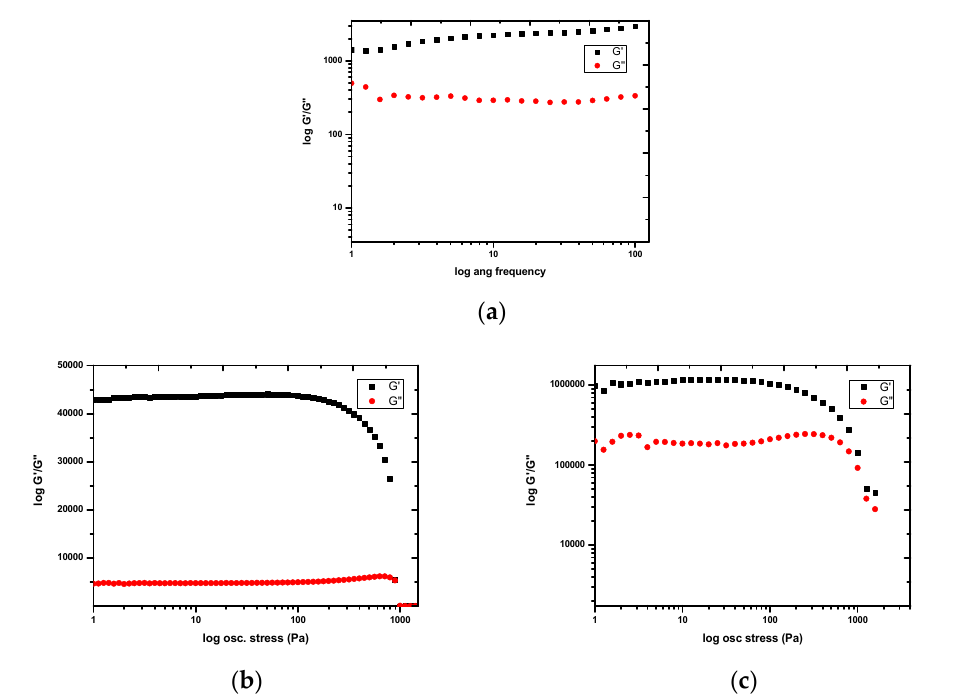
Figure 5. ( a ) Frequency sweep experiment at a concentration of 2% in acetonitrile. Stress sweep experiments at a concentration of 2% wt. for ( b ) G1 in 1-pentanol ( σ = 1000 Pa) and ( c ) G1 in ethanol ( σ = 1995 Pa).